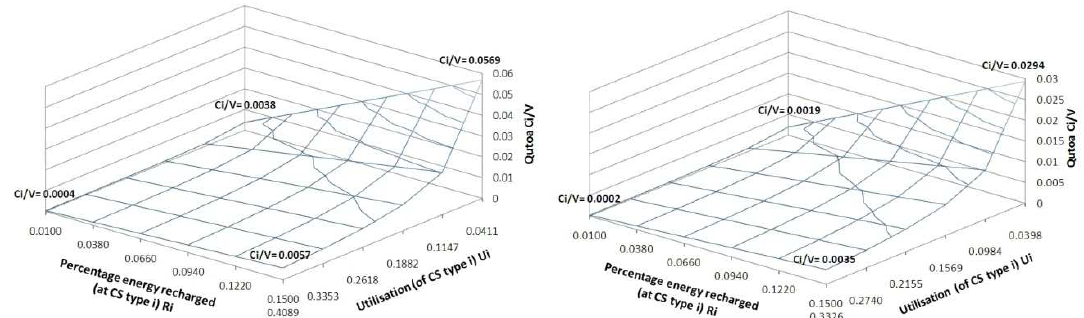
Figure 6. Quotas Ci/V for private vehicles and 22kW (left) and 44kW (right) charging